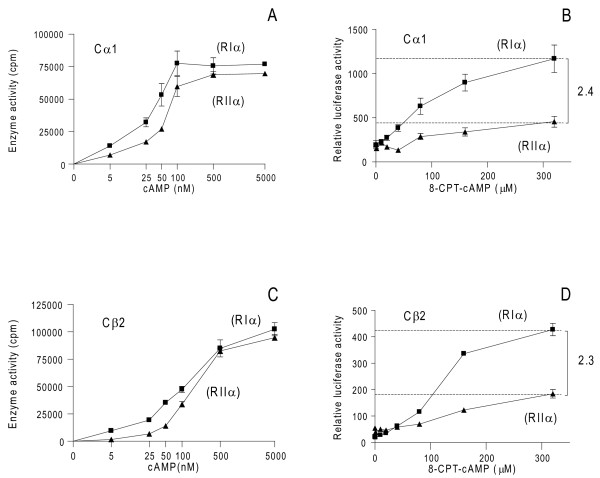
Both PKAI and PKAII are activated to phosphorylate Kemptide but not CREB at saturating conditions of cAMP. 293T cells were co-transfected with a fixed amount (1280 ng) of either pExRIIα or pDeRIα together with pDeCα1 (300 ng) (A and B) or pDeCβ2 (1400 ng) (C and D) for 24 hours. Cell extracts were adjusted to 1 mg total protein/mL and assayed for enzyme activity (cpm,) in the presence of increasing concentrations of cAMP (0 - 5000 nM) (A and C). Identical cell extracts were assayed for relative luciferase activity (B and D). Data points represent relative enzyme activity and luciferase activity, +/- SD (n = 3-6).